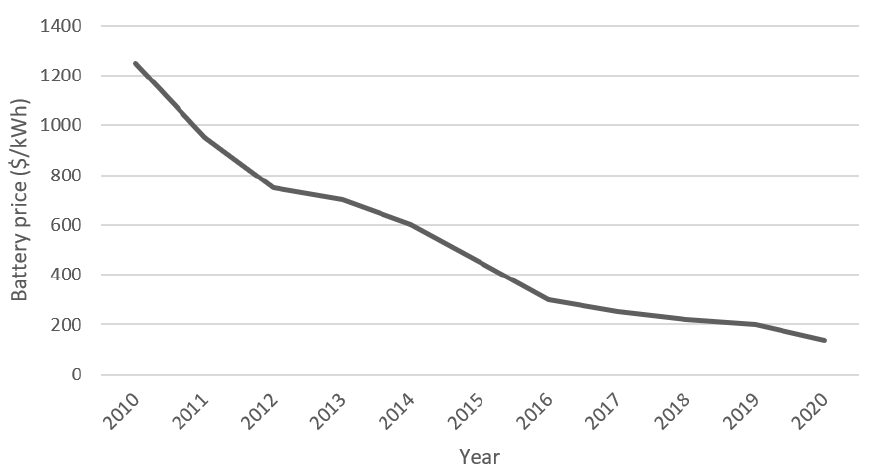
Figure 3. Evolution of the mean price of the batteries in recent years. (Data collected from [53] on 26 May of 2021).